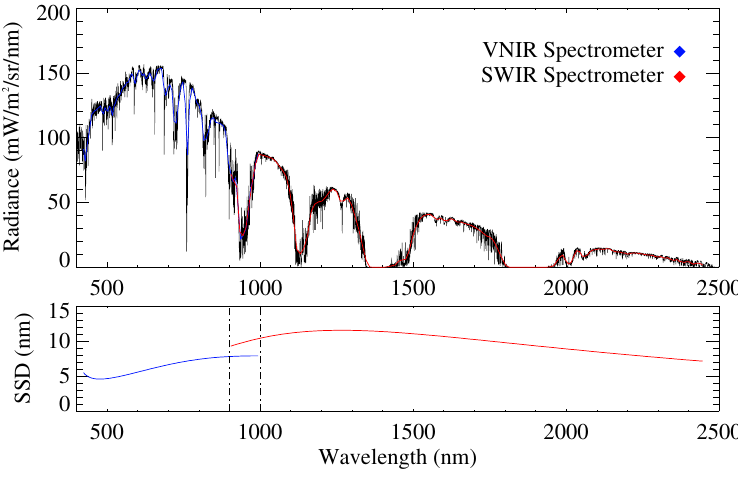
Figure 3. Illustration of EnMAP spectral characteristics. ( Top ) Simulated top-of-atmosphere radiance spectrum for a dry sand surface convolved by the EnMAP spectral response. ( Bottom ) Spectral sampling distance (SSD) as a function of wavelength.